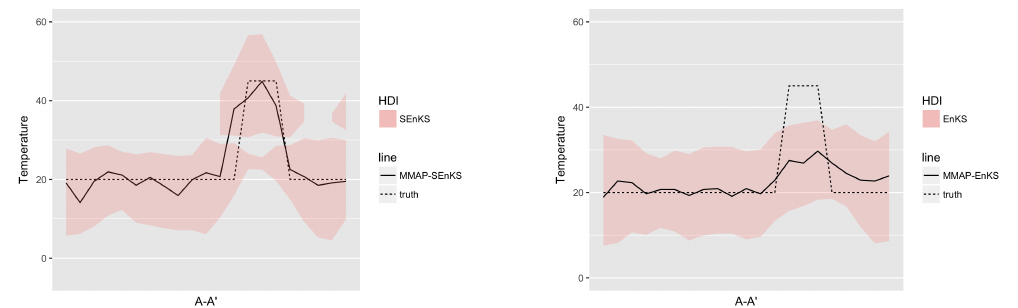
Figure 19. MMAP predictions of the initial temperature ( ◦ C) field ( r 0 | d 0: T ) with 80% HDI in cross section A-A’ at time T = 50 with SEnKS ( left ) and with EnKS ( right ).